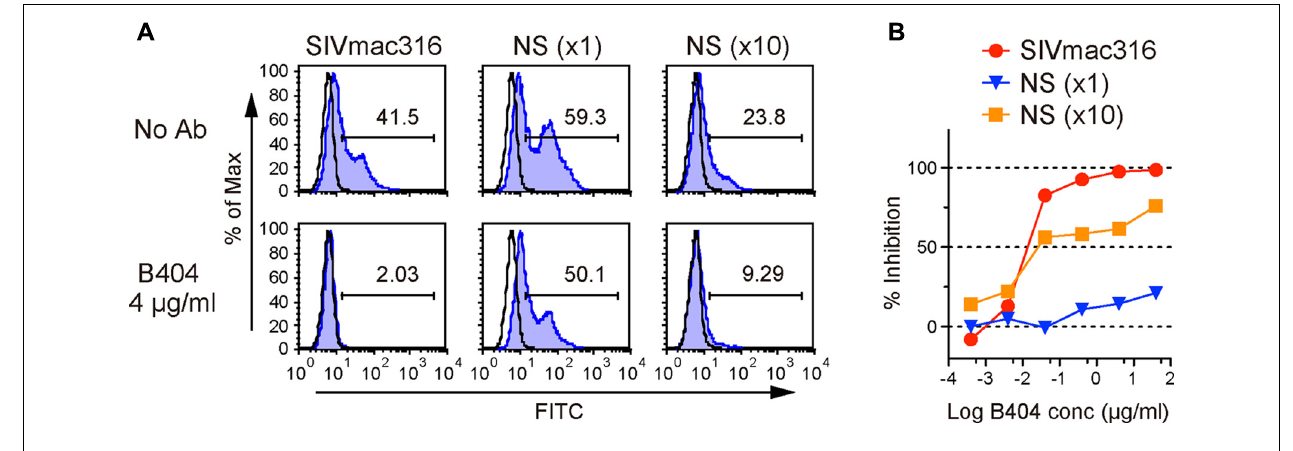
FIGURE 6 | Contribution of gp41 truncation to neutralization resistance in infection of macaque cells. (A) Infection of HSC-F cells in the presence (4 μ g/ml) or absence of Fab-B404 is shown. HSC-F cells were inoculated with undiluted SIVmac316 and NS, and 10-fold diluted NS.Viral infection was